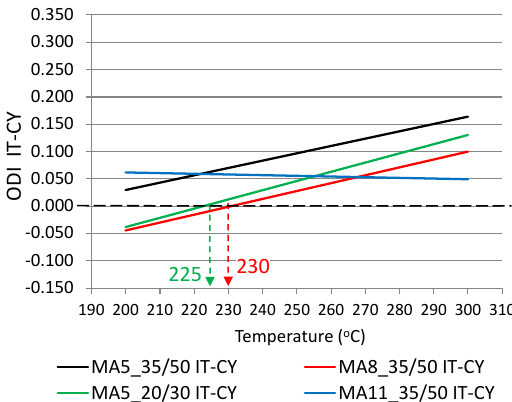
Figure 12. Overheating Degradation Index for IT-CY stiffness of mastic asphalts MA5, MA8 and MA11 with bitumens 35/50 and 20/30 and determination of temperature T (ODI) .